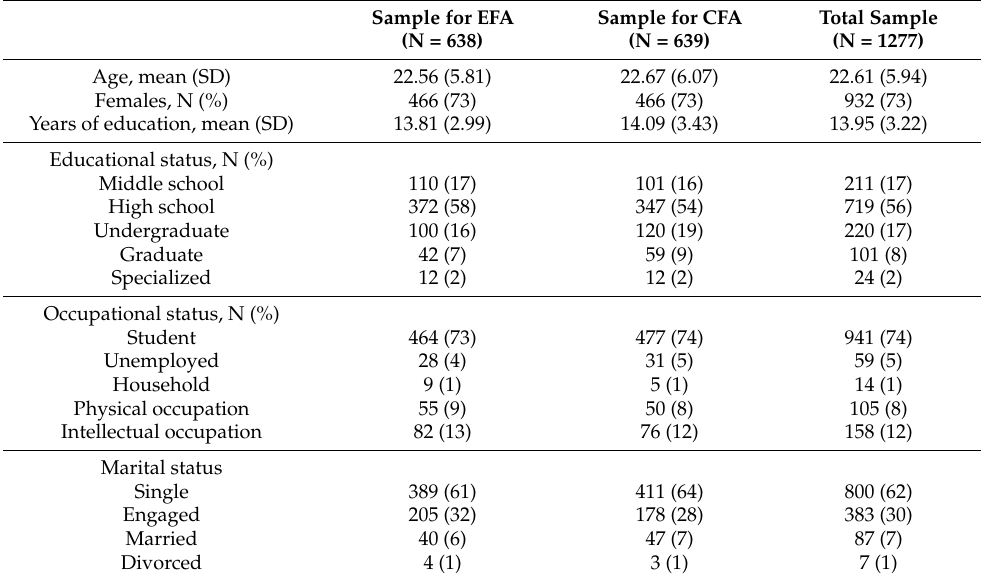
Table 1. Characteristics of the samples for the EFA and